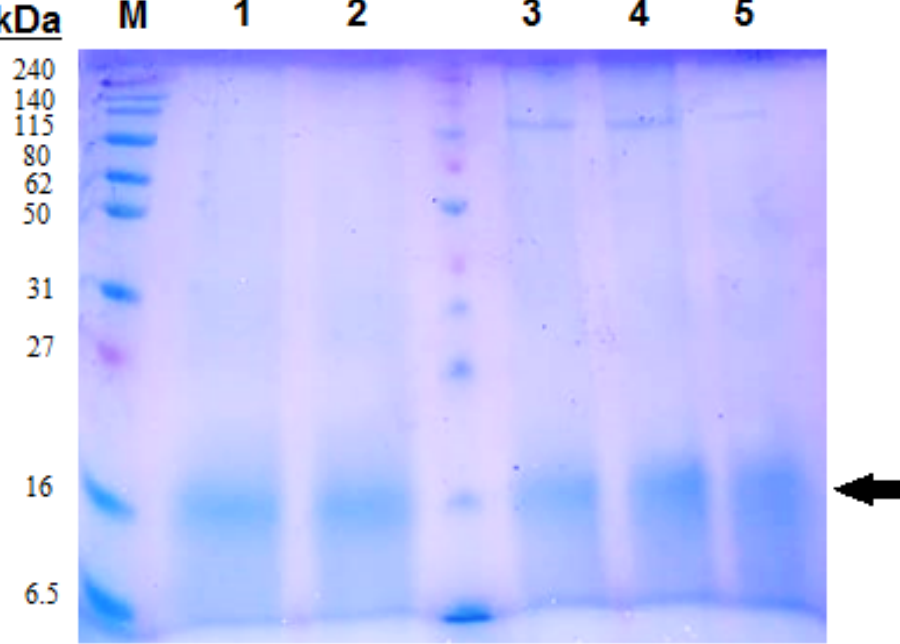
Figure 3. The 12% SDS-PAGE analysis of the extracted C-phycocyanin from dry biomass of the three microalgae strains. M: Protein molecular weight marker; 1, 2: C-phycocyanin extract from the Chinese strain; 3, 4: C-phycocyanin extract from the French strain; 5: C-phycocyanin extract from the Egyptian strain. The arrow points to C-phycocyanin subunits.